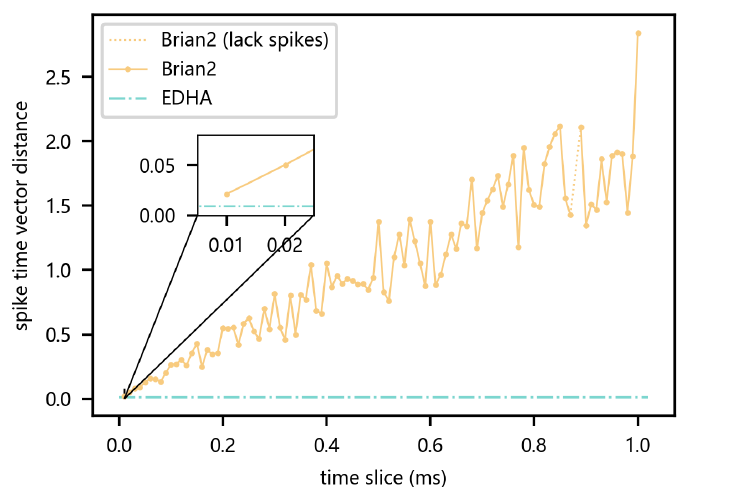
Figure 8. The comparison of spike time accuracy between Brian2 and